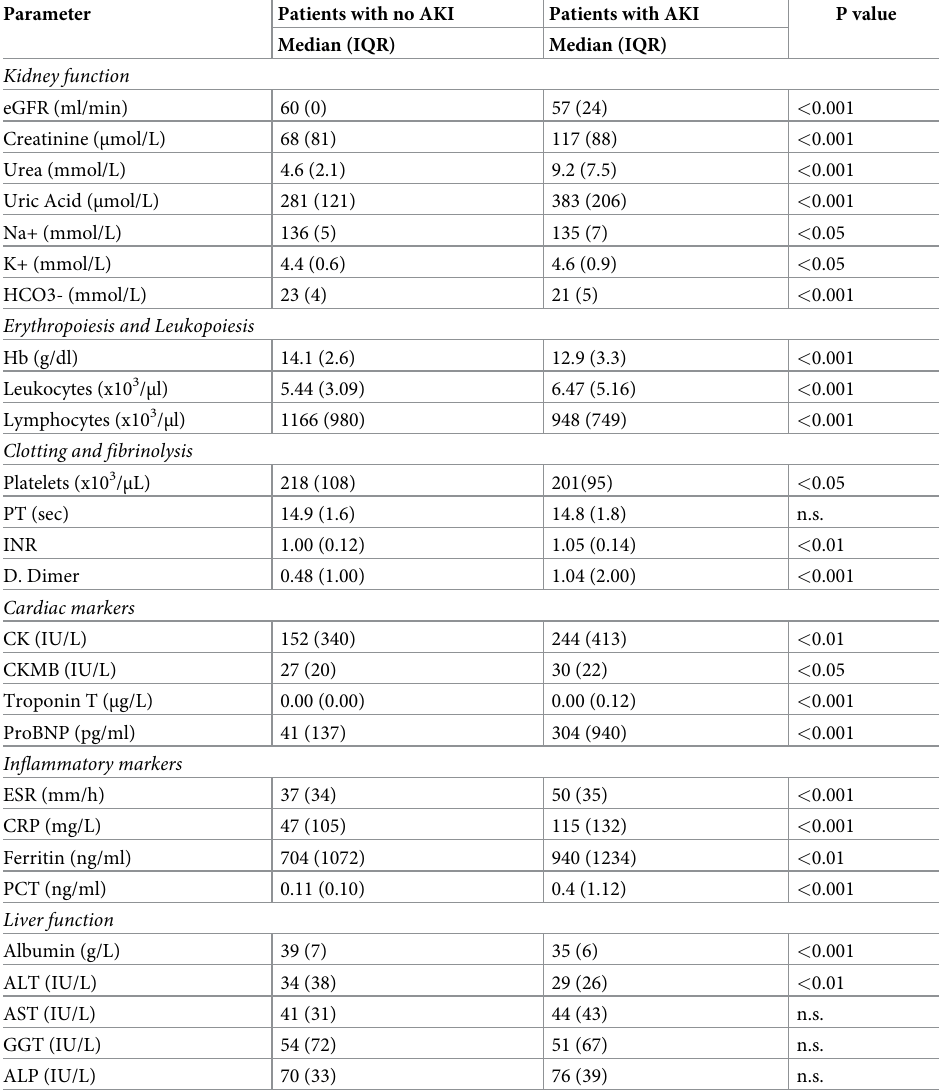
Table 2. Laboratory data at the time of admission for the two groups of COVID-19 infected